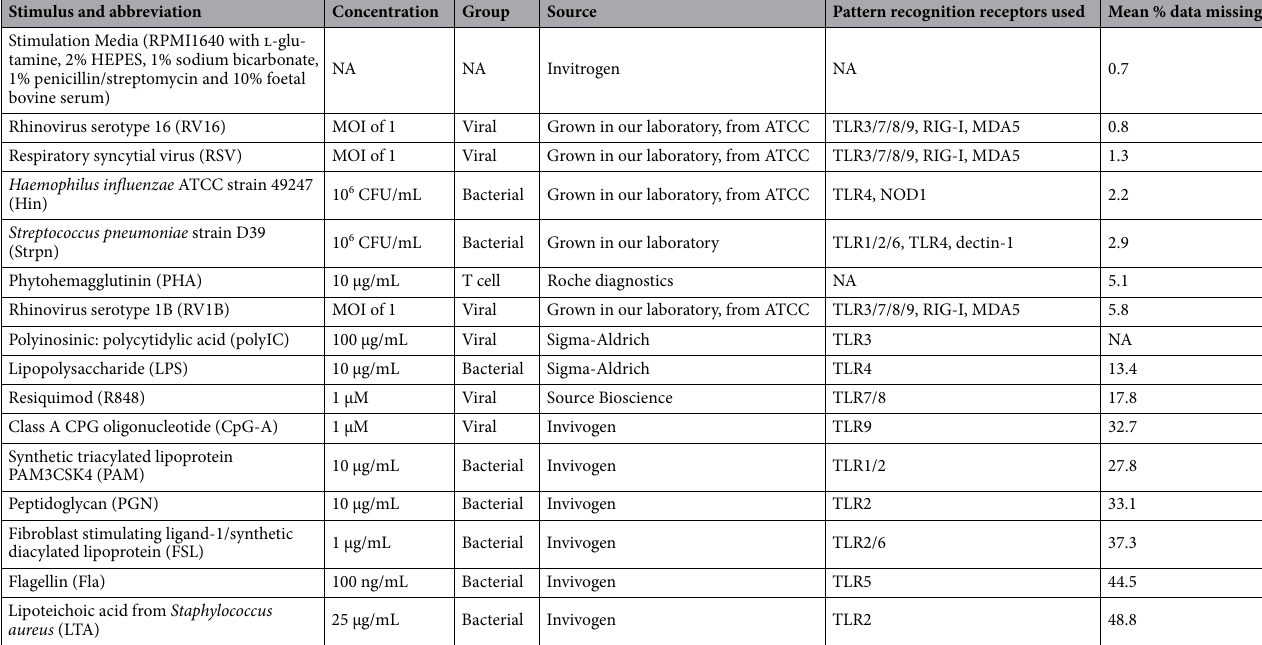
Table 1. Infectious agents, Toll-like receptor (TLR) ligands and other stimuli used to stimulate peripheral blood mononuclear cells (PBMCs). MOI multiplicity of infection, CFU colony-forming unit, TLR